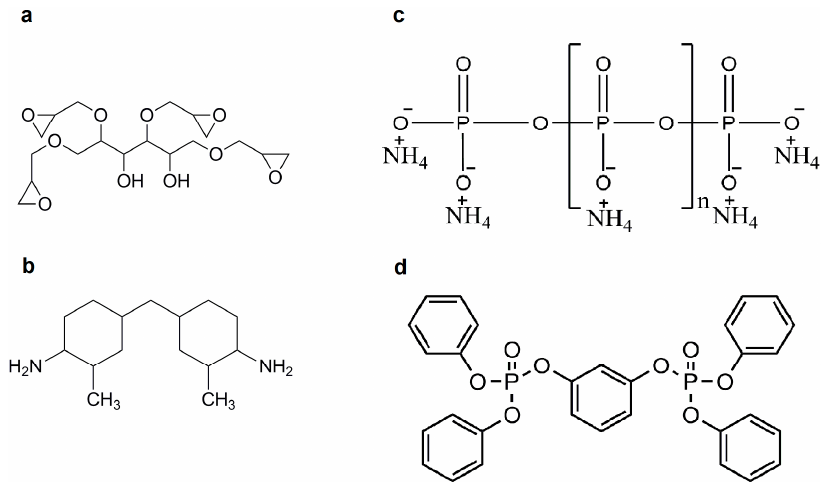
Figure 1. Chemical structures of the applied components sorbitol polyglycidyl ether (SPE) ( a ); Cycloaliphatic amine (T-58) ( b ); ammonium polyphosphate (APP) ( c ); and resorcinol bis(diphenyl phosphate) (RDP) ( d ).